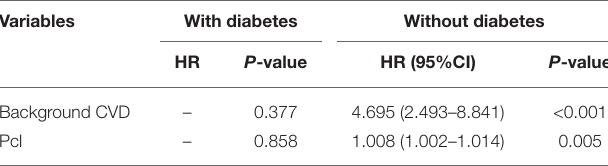
TABLE 6 | Multivariate Cox regression (enter backwards) models for all-cause mortality [expressed as hazard ratios, 95% CI’s, and p-value]. Variables HR (95%CI) P -value